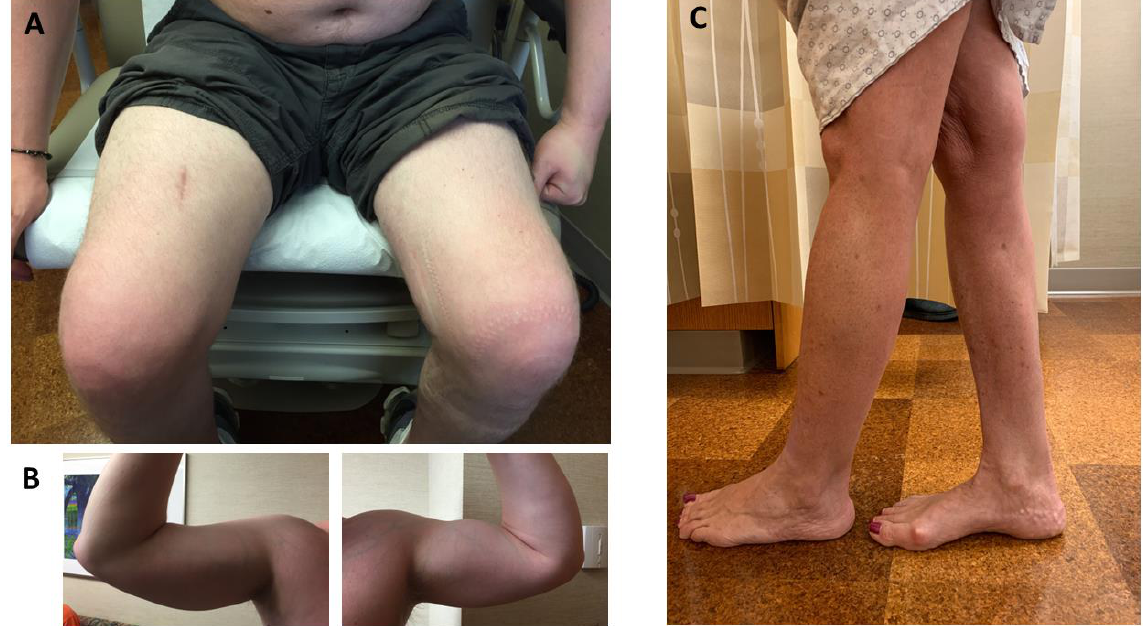
Figure 2. Clinical findings of a patient with ANO5 limb–girdle muscular dystrophy (LGMDR12) and recurrent rhabdomyolysis ( A , B ) and a patient with ANO5 distal myopathy of Miyoshi type (MMD3) ( C ). A. Asymmetric atrophy of quadriceps. B Asymmetric atrophy of biceps brachii. C. Asymmetric atrophy of gastrocnemius.